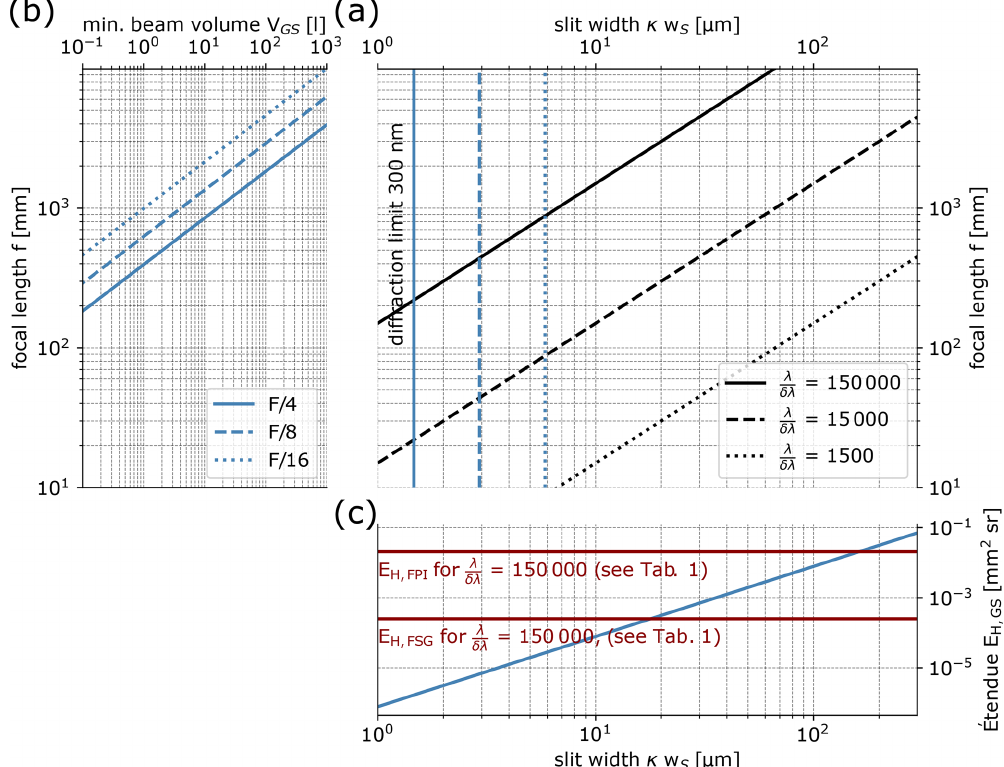
Figure 4. Combined visualisation of Eqs. (20)–(22) and (24). (a) For three exemplary resolving powers (1500, 15000, and 150000), the possible slit-width-to-focal-length ratios are shown. The focal length determines the spectrograph’s size scaling (b) , whereas the slit width determines its étendue (blue line in c ). The étendue of the FPI spectrograph with the grating OSM (for an incidence angle of 0 . 5 ◦ ) and the total étendue of the FPI (i.e. the FPI spectrograph with an interferometric OSM) with the specifications given in Table 1 are shown in